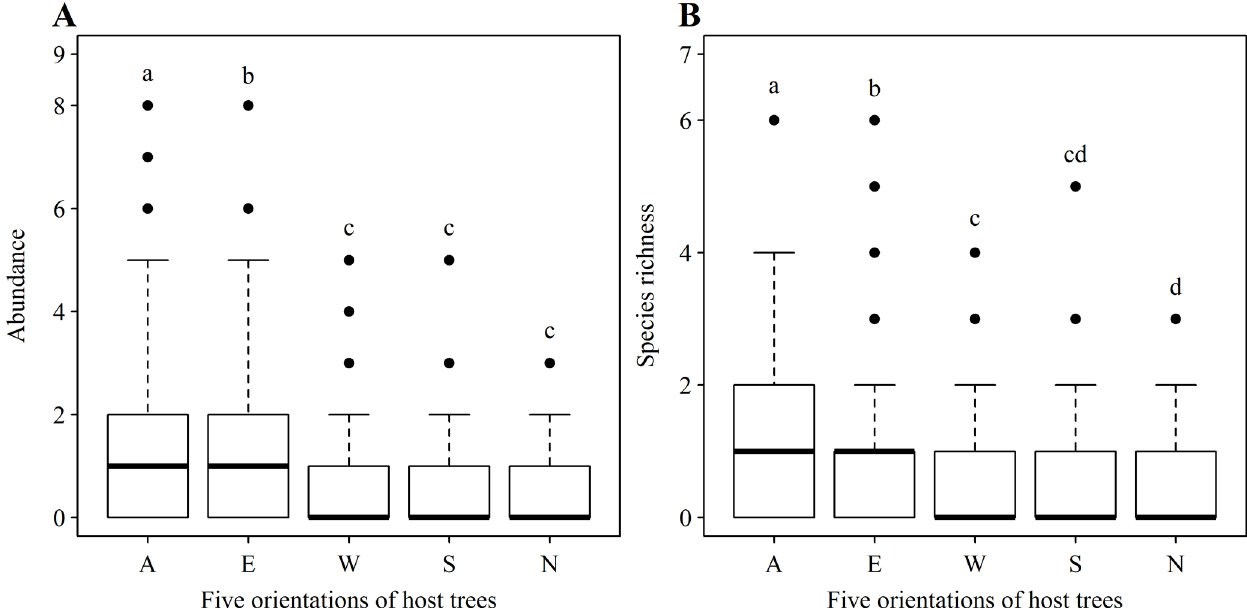
Fig 3. Abundance (A) and species richness (B) of vascular epiphytes at the five orientations upon host trees. Different letters above boxes indicated significant difference for alpha = 0.05. A, E, S, W and N indicated the five orientations of all directions, east, south, west and north where epiphytes grew upon host trees, respectively.